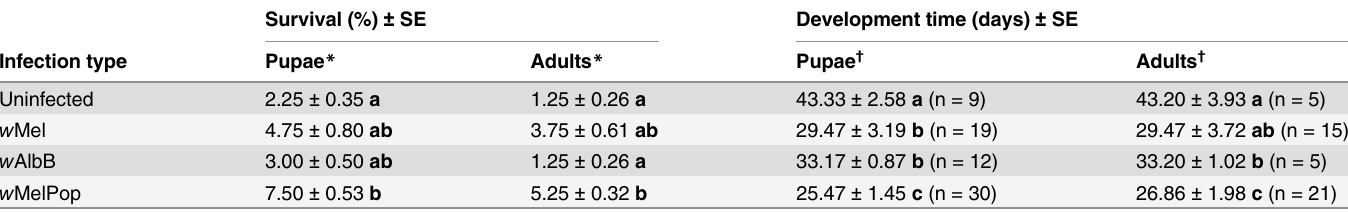
Table 1. Pupation and adult emergence from Ae . aegypti larvae held under starvation conditions in groups of 50.